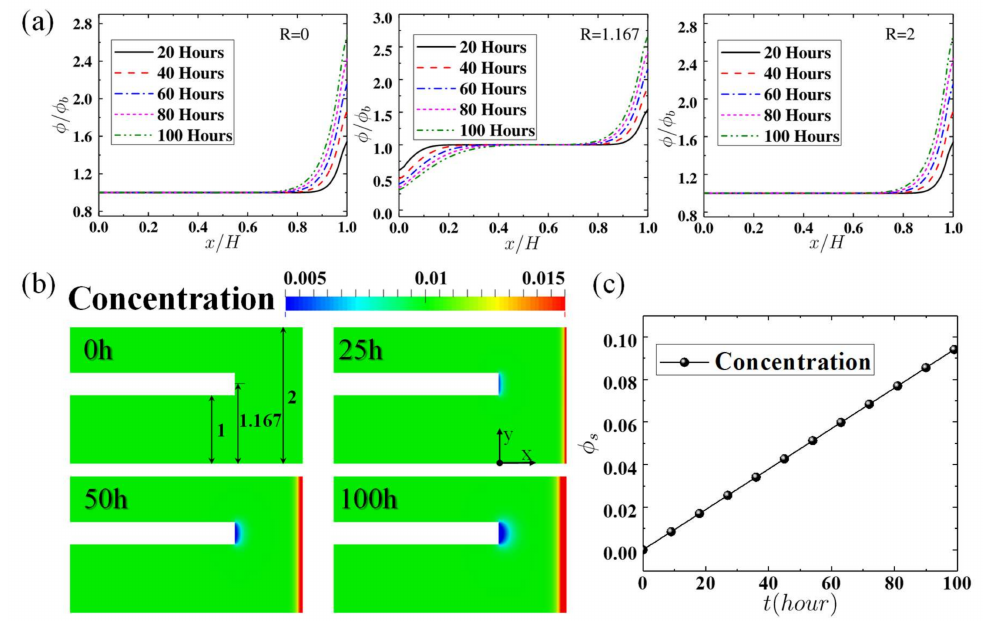
Figure 2. ( a ) Time evolution of the concentration profiles along the X-direction at different radial (Y) positions, R = 0, 1.167, and 2. ( b ) The concentration field near the borehole bottom at different times. ( c ) Nanoparticle accumulation, φ s , as a function of